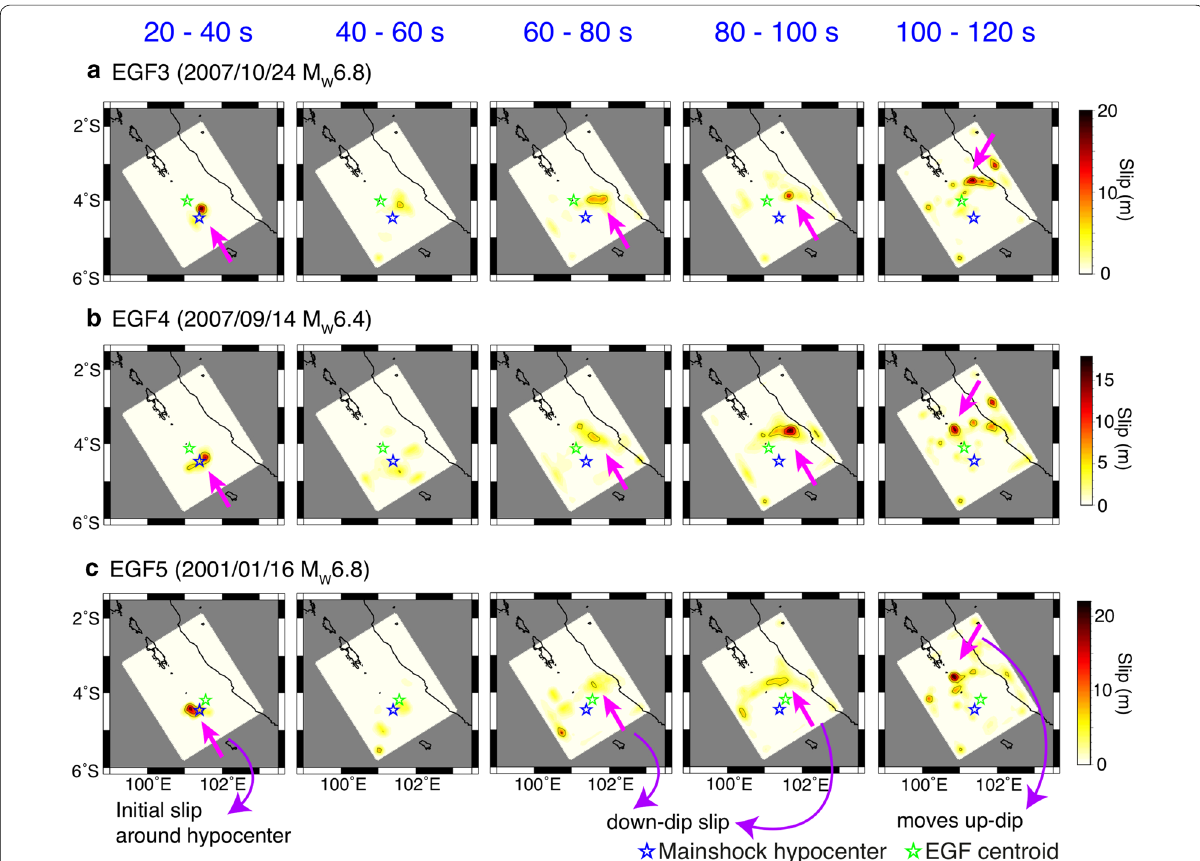
Fig. 3 Comparison of the spatiotemporal slip distribution using different EGFs for the Bengkulu Earthquake. Spatiotemporal slip distributions for each 20‑s interval of the Bengkulu Earthquake using a EGF3 (24 Oct 2007, M W 6.8 ), b EGF4 (14 Sep 2007, M W 6.4 ), and c EGF5 (16 Jan 2001, M W 6.8 ). Blue stars mark the hypocenter of the Bengkulu Earthquake in the ISC catalog (International Seismological Centre 2019), and green stars represent the centroids of the relocated EGF event. Pink arrows indicate notable slip features (see “The 2007 M W 8.5 Bengkulu Earthquake” section for further